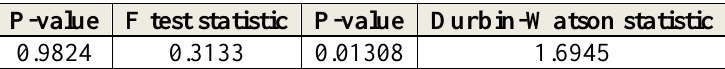
Table 7. Test of model significance and autocorrelation